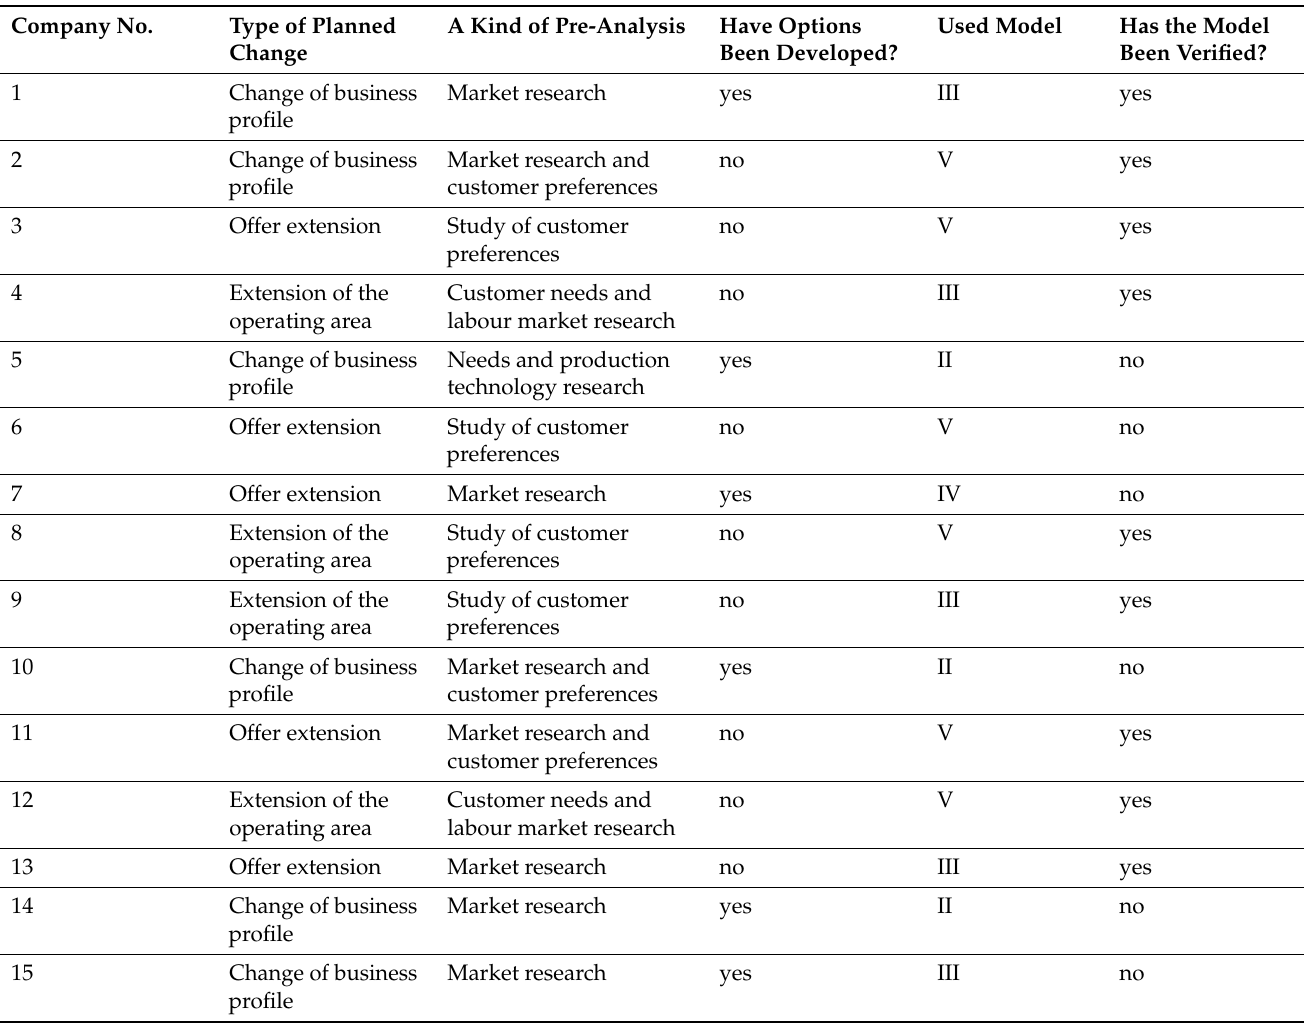
Table 4. Specification of the information on strategic decisions (concerning a change in the profile and scope of